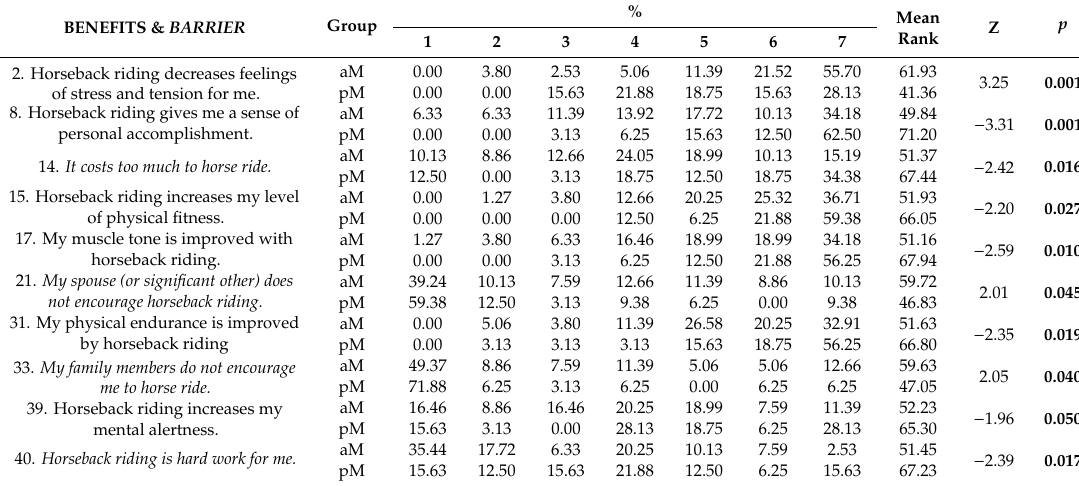
Table6. Comparisonofmaleparticipantsbasedonspecializeddegree: amateurs(n = 79)vsprofessionals (n = 32), ( p < 0.05). (1–7 Likert scale: 1—this issue concerns me to a very low degree; 7—this issue concerns me to a very high